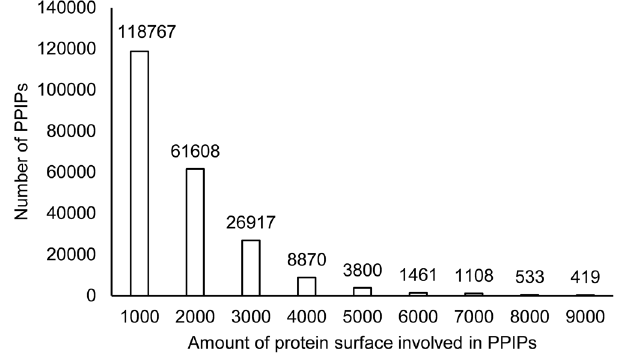
Figure 6. Protein surface area contributed in PPIPs.